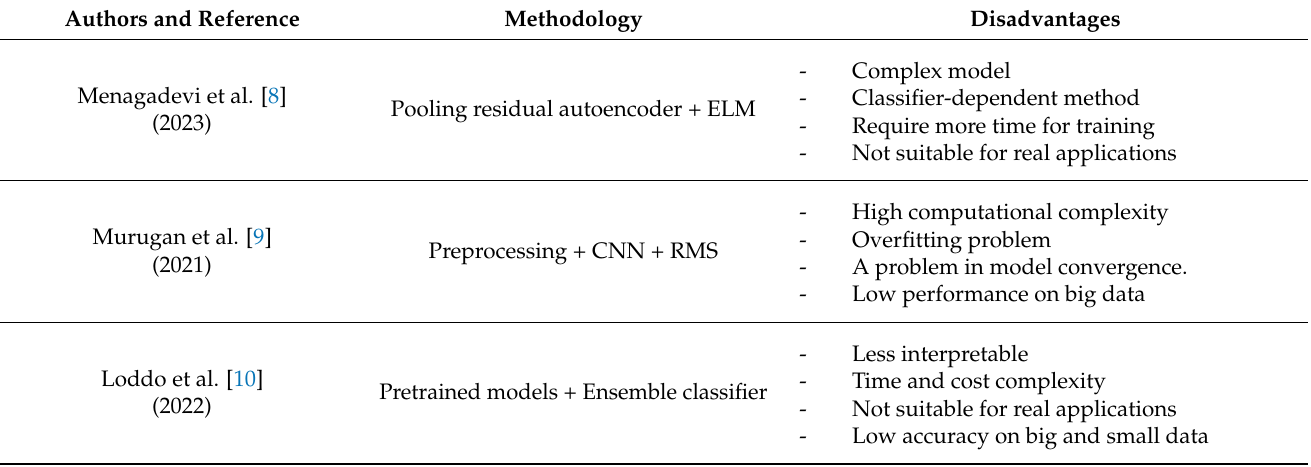
Table 1. Summary of previous works for AD detection based on deep